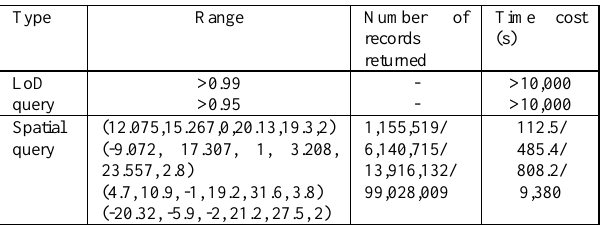
Table 4. Query performance of the SDO_PC solution.